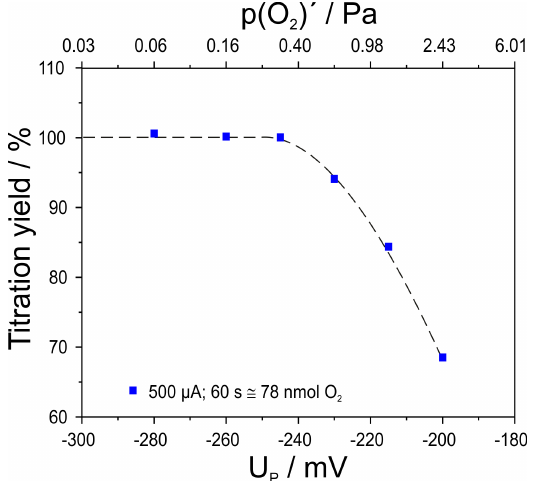
Figure 5. Titration yield for an oxygen pulse of 500µA for 60s (78nmol O 2 ) depending on the adjusted basic oxygen partial pres- sure; flow rate 50mLmin − 1 ; cell temperatures 750 ◦